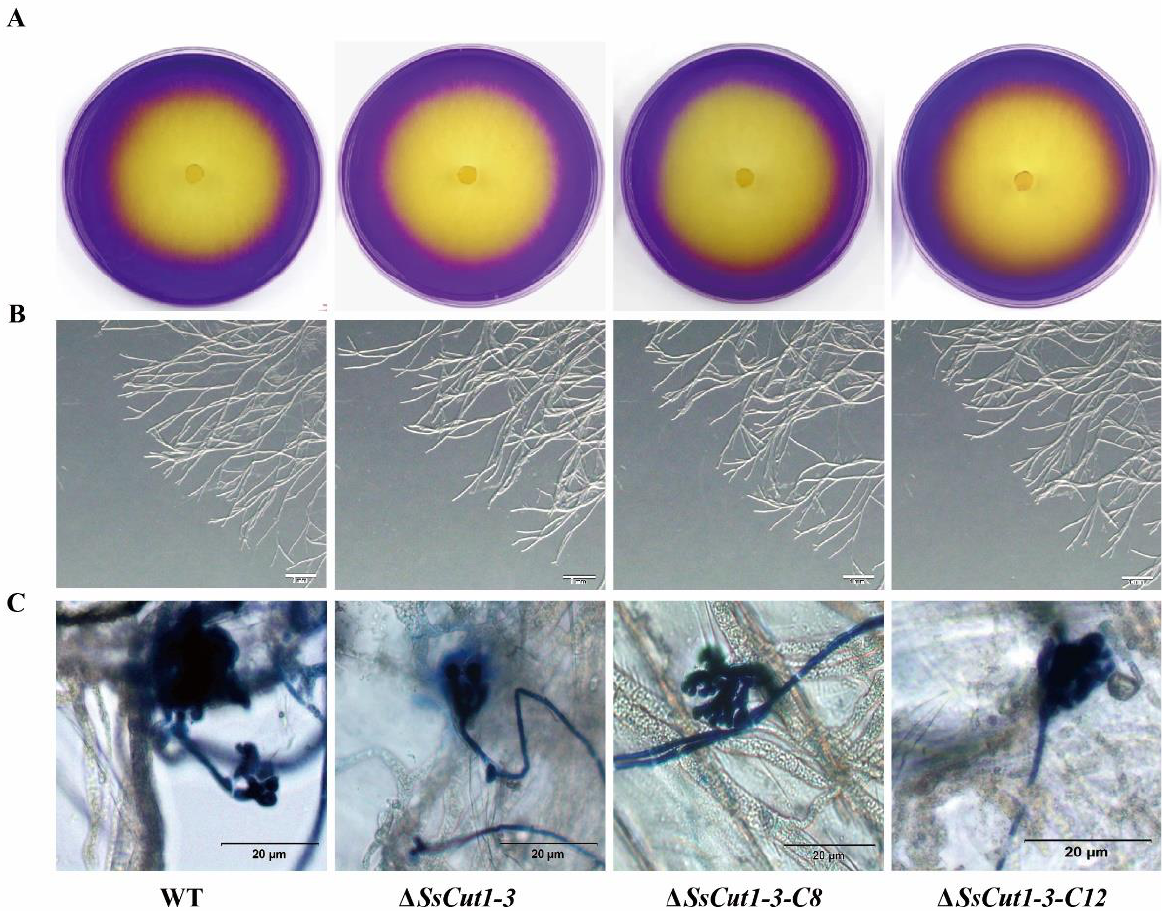
Figure 4. The deletion of SsCut1 has no significant effect on oxalate production, hypha morphology and infection cushions formation. ( A ) Qualitative determination of acid produced by the wild-type strain and SsCut1 transformants on PDA medium containing 0.005% ( w / v ) bromophenol blue dye as a pH indicator. The presence of yellow indicates that acid was produced. Photographs were taken at 36 hpi. ( B ) In vitro hyphal development of the wild-type strain and SsCut1 transformants. All strains were cultured on PDA medium for 36 hpi. Hyphal tips were observed under a dissecting microscope. Bars = 500 µ m. ( C ) Infection cushions formation of wild-type strain and SsCut1 transformants. Microscopic observation of infection cushions of wild-type strain and SsCut1 transformants on onion epidermal cell layer after staining with trypan blue. Photographs were taken at 14 hpi. Bar = 20 µm.